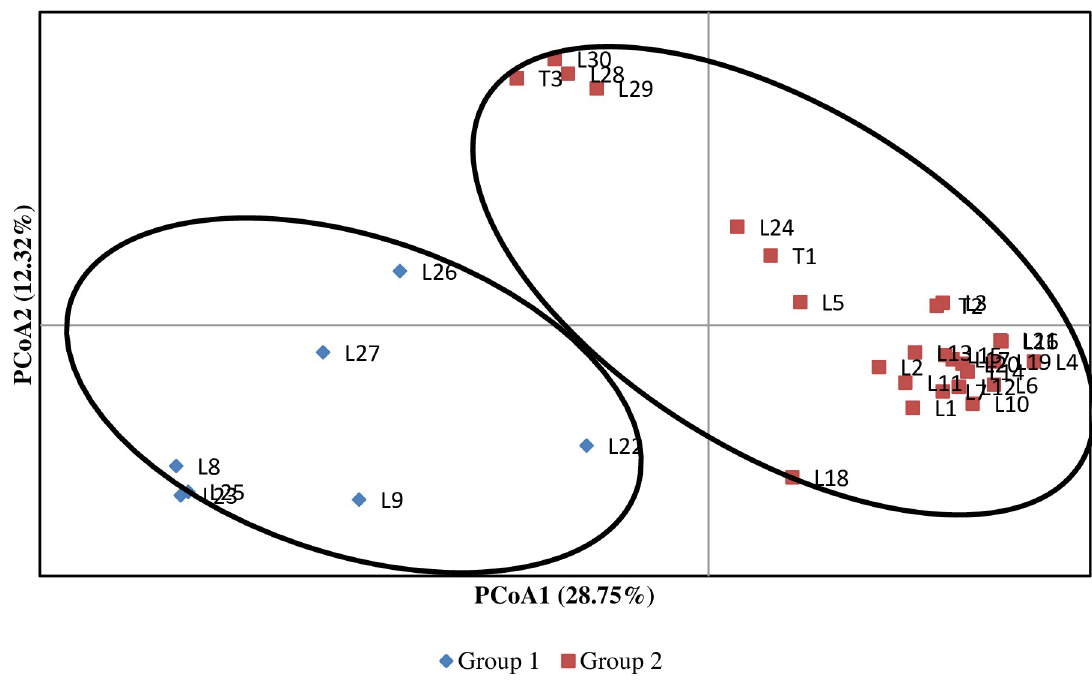
Fig 5. Plots of value for the first two principal coordinates of the S . hermonthica resistant inbred lines and testers with varying levels of Striga resistance determined based on clusters identified by population structure